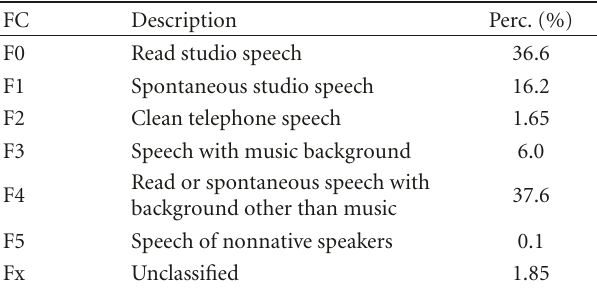
Table 1: Focus conditions of the BNSI